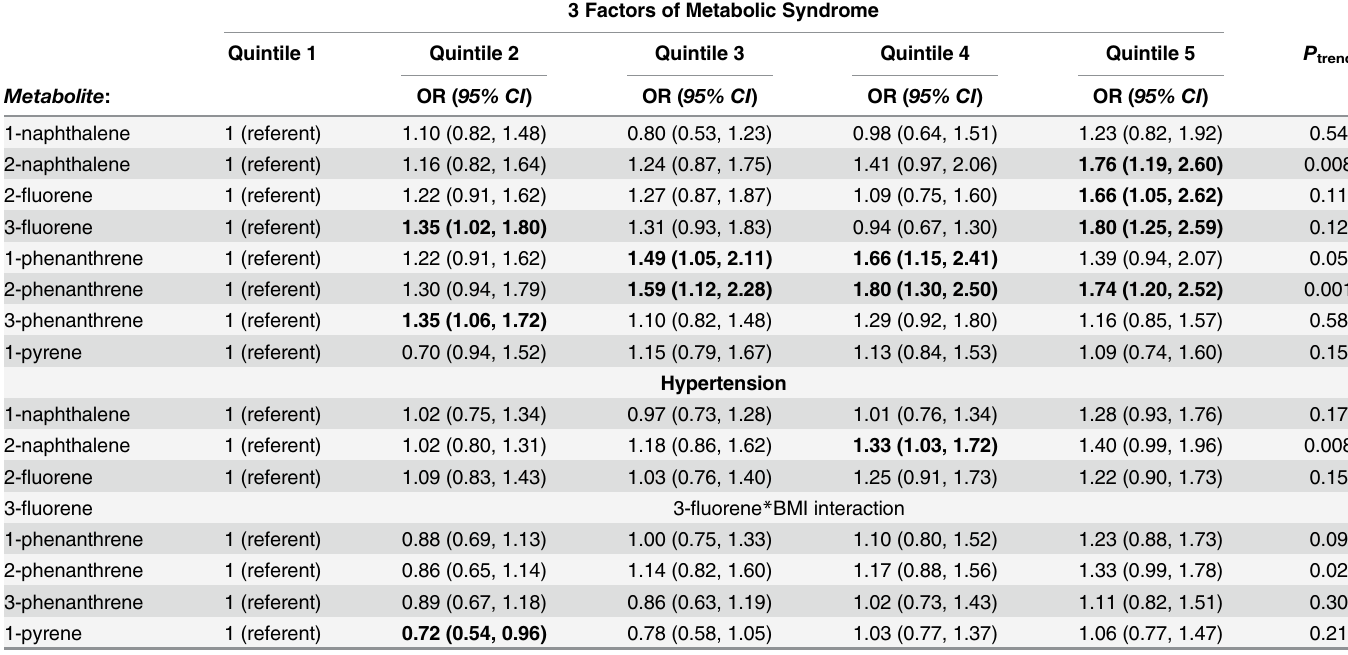
Table 3. Weighted and adjusted odds ratios for quintiles of PAH and 3+ factor metabolic syndrome and